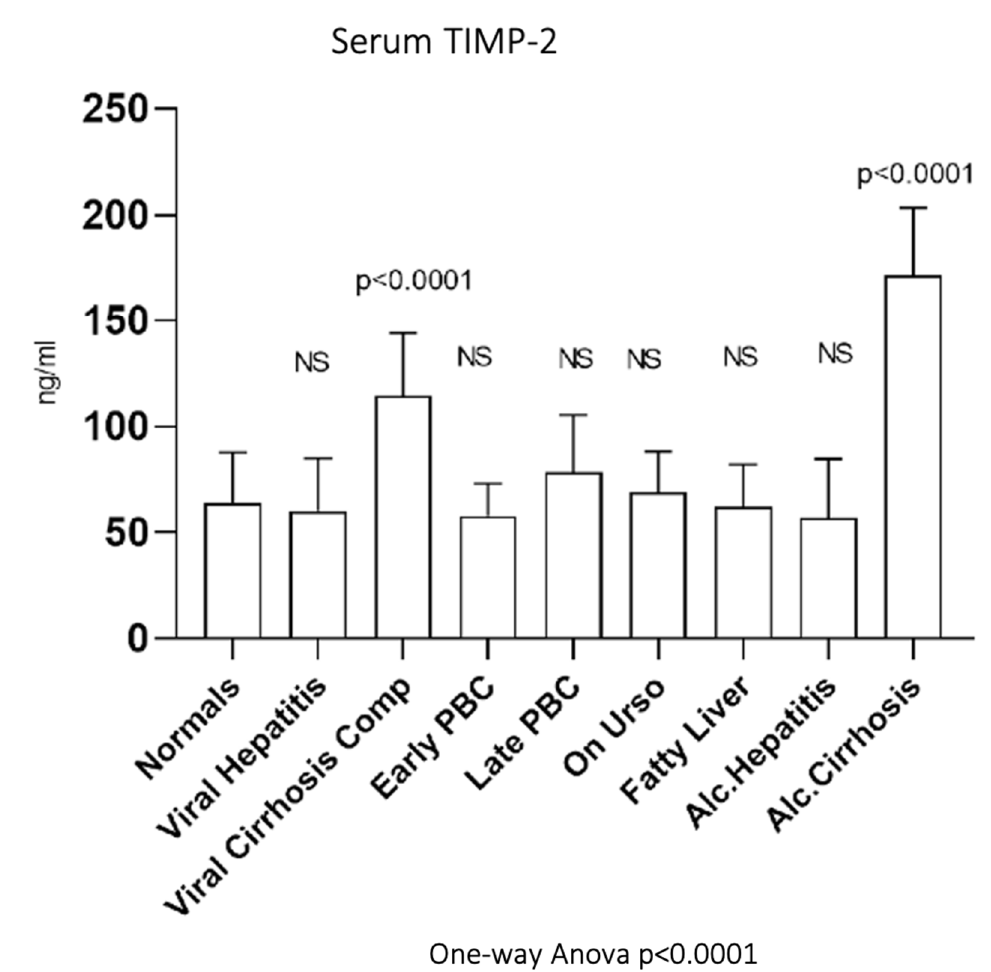
Figure 10. Serum TIMP-2 in all studied groups.